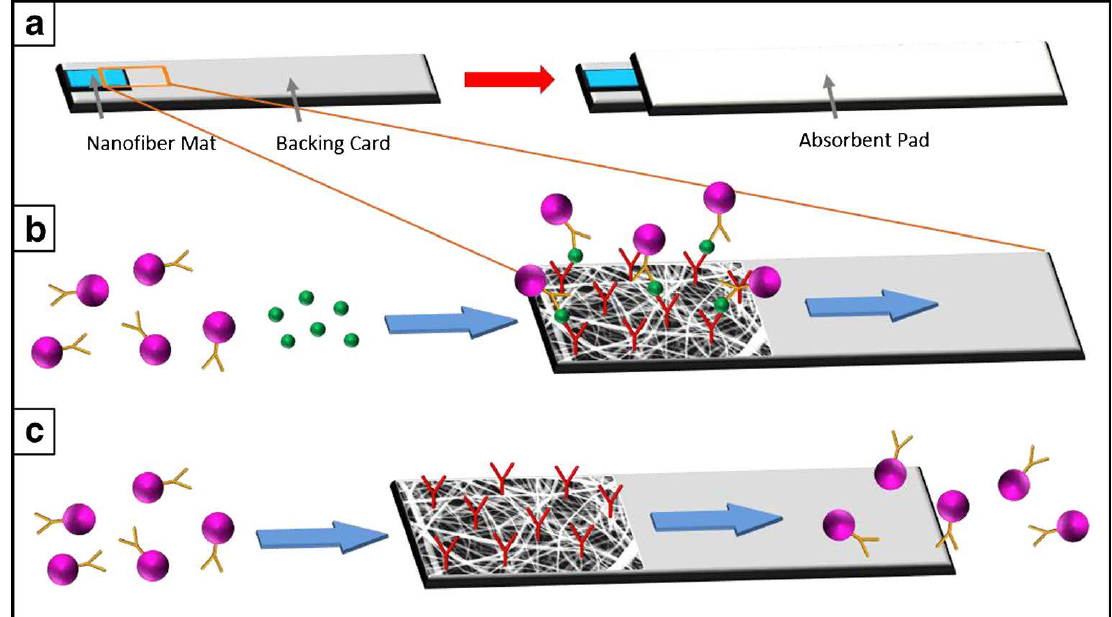
Figure 1. Illustration of a lateral flow assay using an electrospun nanofiber mat instead of the classic nitrocellulose membrane: ( a ) sample flows through the mat into the absorbent pad; ( b ) E. coli (green) are captured by the antibodies (red) on the mat, and following horseradish peroxidase (HRP), linked antibodies (pink/orange) are immobilized, catalyzing a colorimetric signal in place when the HRP substrate is added; ( c ) if E. coli is not present in the sample, no binding of the secondary antibody can occur, and the enzyme is transferred to the absorbent pad. Reprinted by permission from Springer Nature: Springer Anal. Bioanal. Chem. [17]. Copyright 2013.